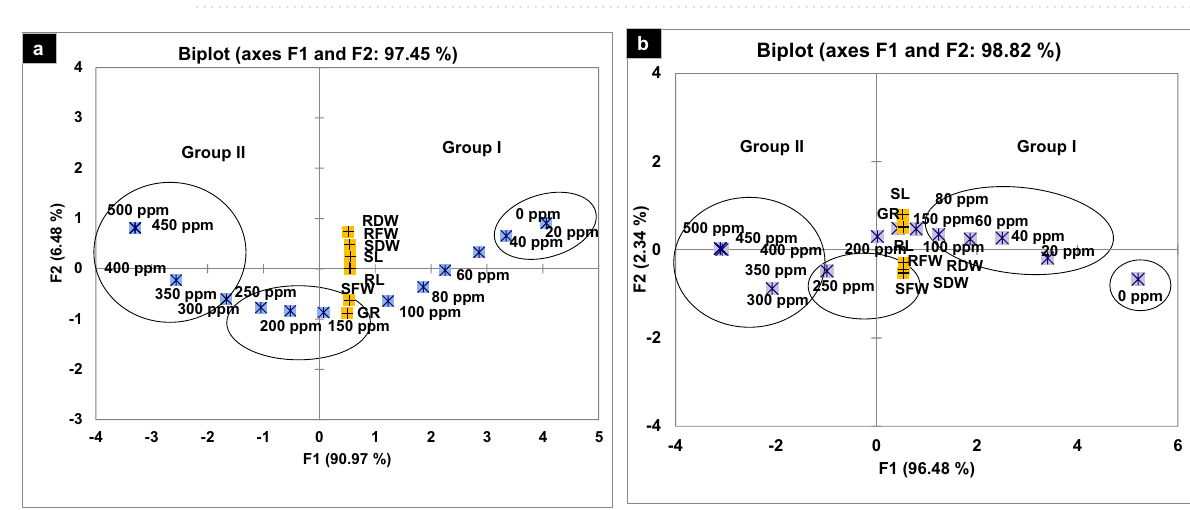
Figure 2. ( a and b ) Regression analysis for the relationship between tolerance indices (%) of tomato against 13 different concentrations of Cr(III) and Cr(VI) for 15-day-old tomato seedling in Petri plate bioassays.